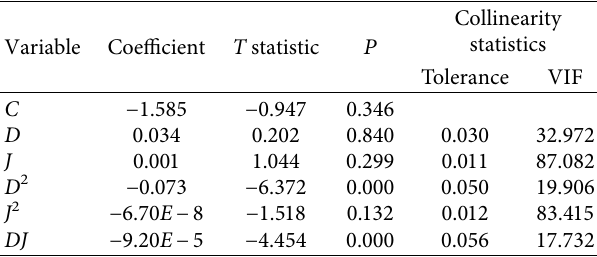
Table 10: Significance of coefficients (mean absolute values of the acceleration slopes).